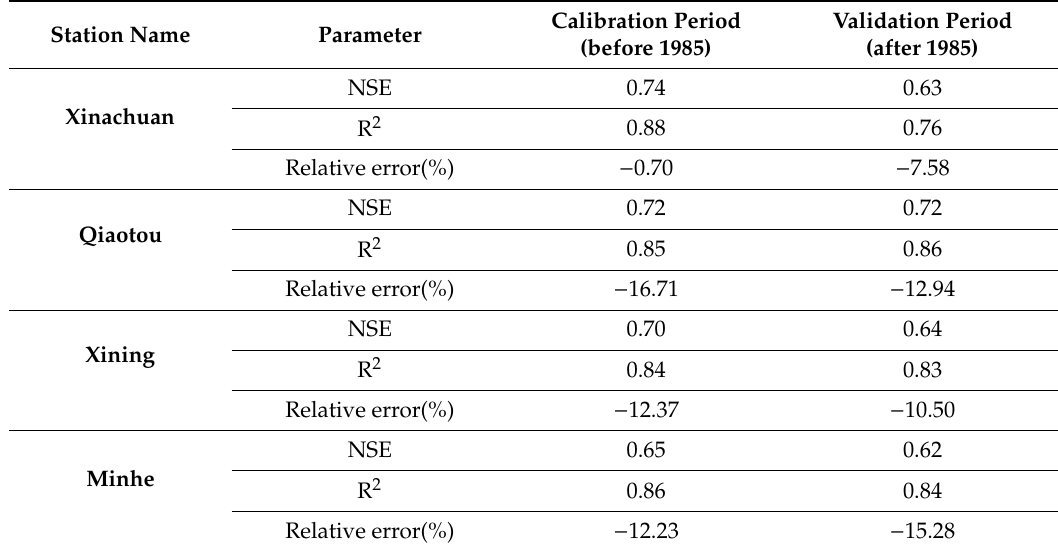
Figure 10. The observed and simulated monthly discharge at the four hydrological stations for the calibration period (1965–1985) and the validation period (1986–2017). Table 6. Calibration and validation results for the monthly runoff at hydrological stations.